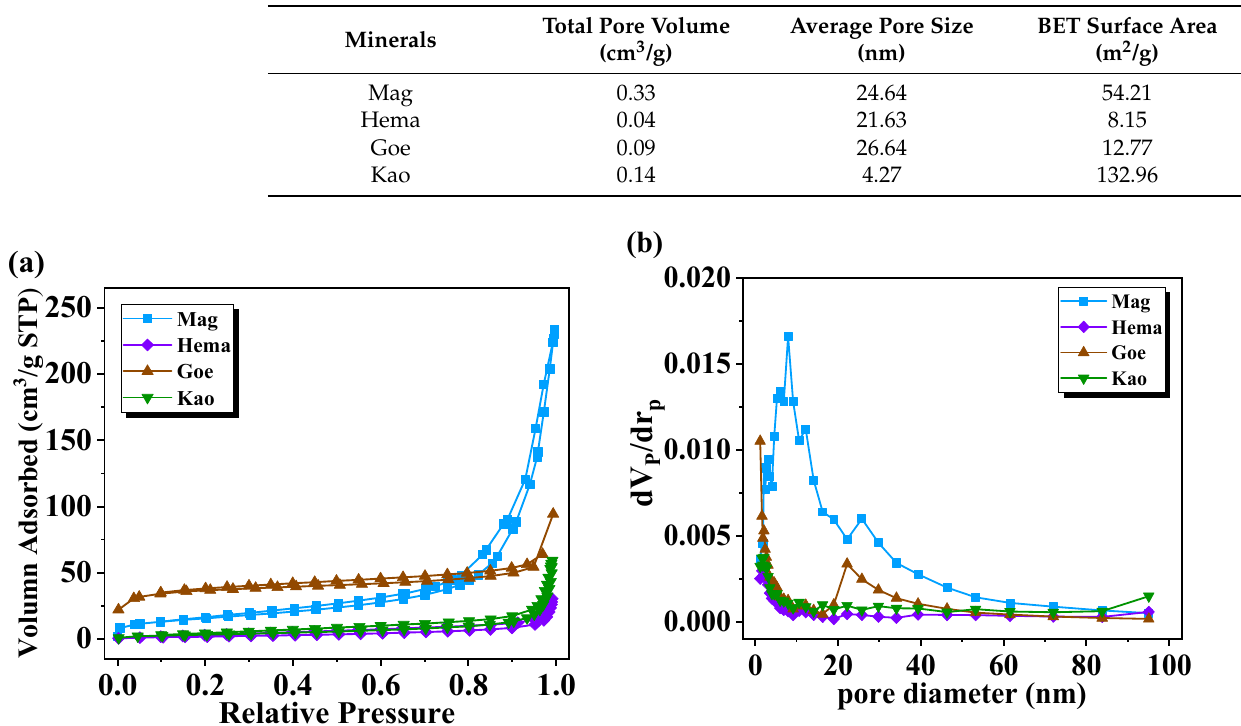
Figure 3. ( a ) N 2 adsorption-desorption isotherms and ( b ) pore size distributions of Mag, Hema, Goe and Kao.